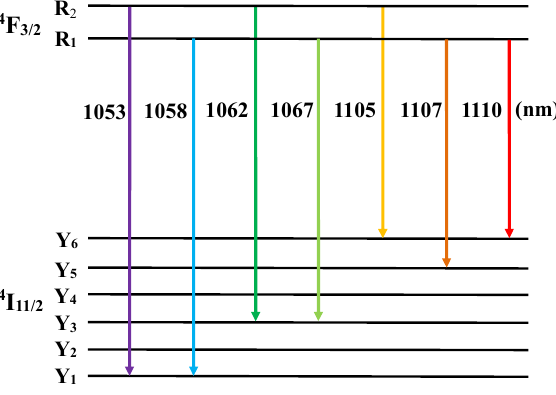
Figure 3. Energy-level transitions of 4 F 3/2 → 4 I 11/2 excited at 808 nm for Nd:GYSGG.